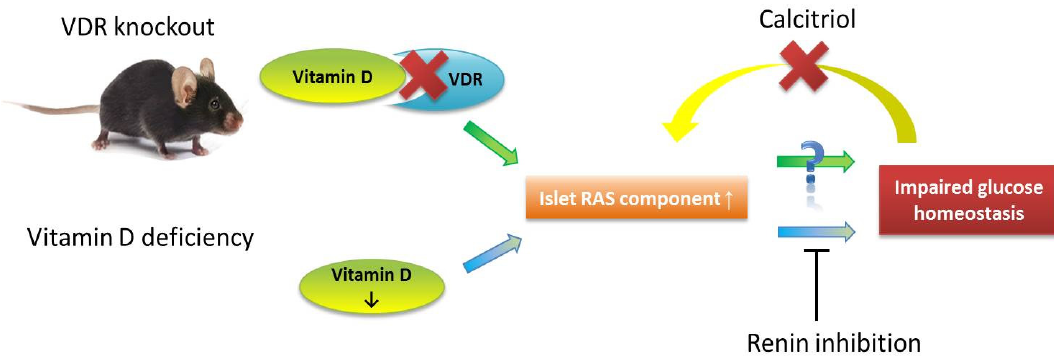
Figure 3. Model of vitamin D in the regulation of pancreatic islet beta-cell function and survival in a diabetic state.